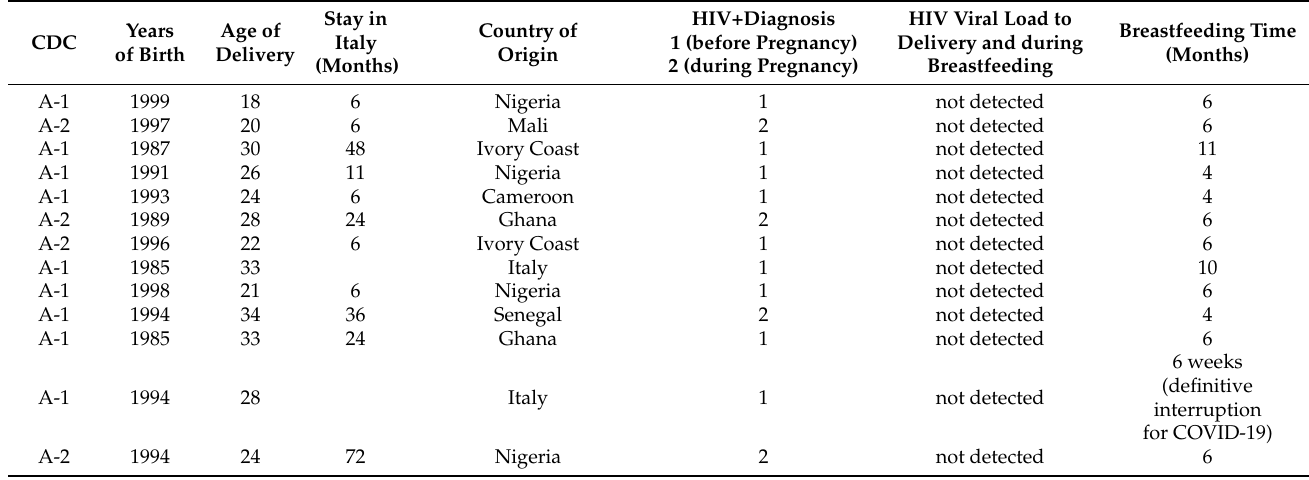
Table 2. Clinical, social, and demographic findings of 13 cohort female patients.